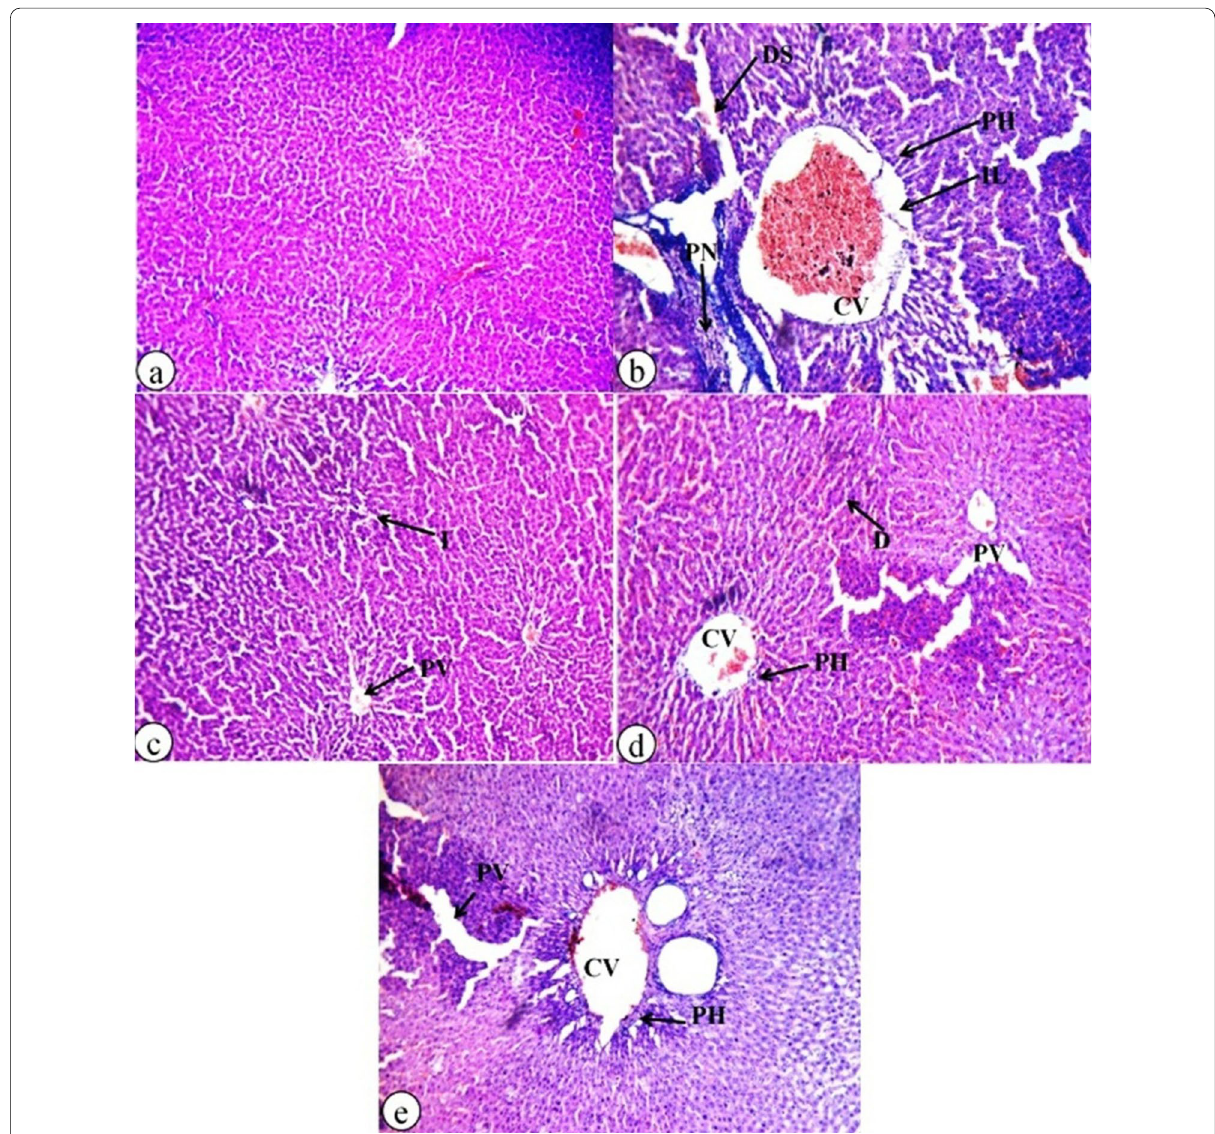
Fig. 6 Photomicrograph of the effect of administration of ethanolic extract of L. rugosa on the histology of the liver; a normal control; b CCl 4 hepatotoxic control; c CCl 4 hepatotoxic treated with silymarin; d CCl 4 hepatotoxic treated with 200 mg/kg b.w LR; e CCl 4 hepatotoxic treated with 300 mg/kg b.w LR. I: inflammation; PH: periportal hypertrophy; IL: infiltration of leukocyte; D: deterioration of hepatic parenchyma; PN: periportal necrosis; DS: dilation of sinusoidal capillary; CV: central vein; PV: portal